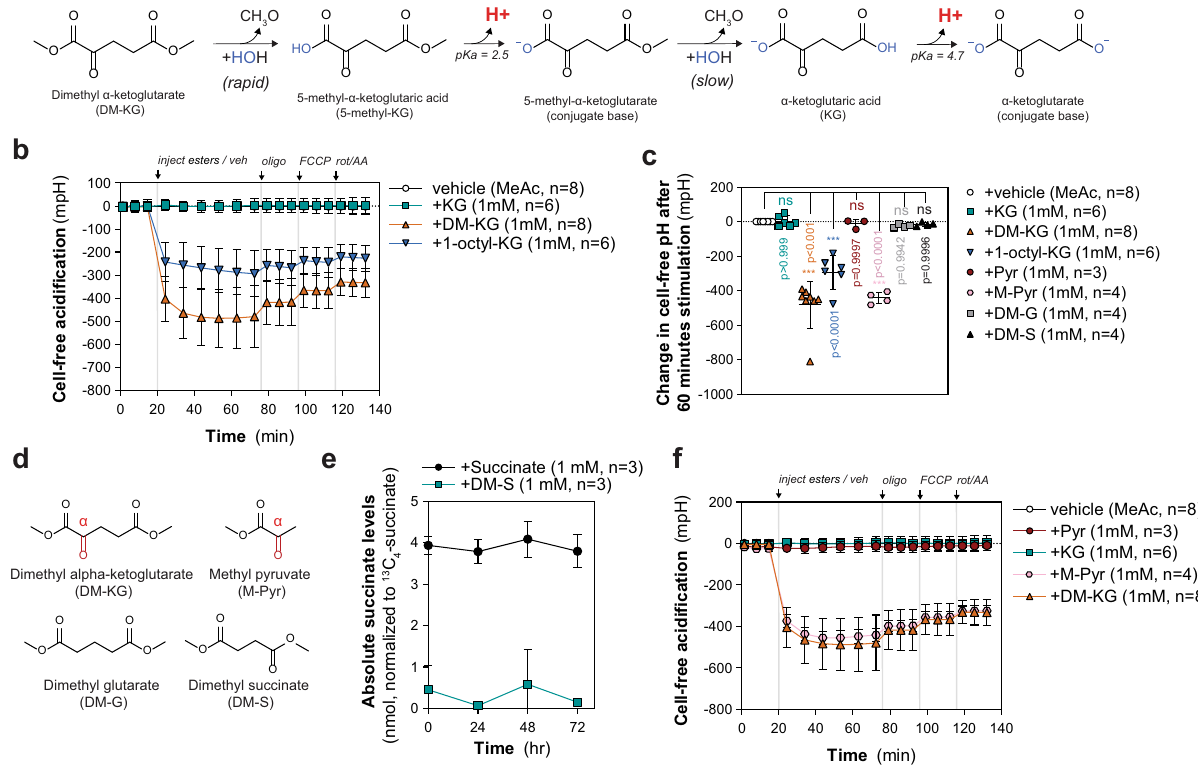
Fig. 4 α -ketoesters signi fi cantly acidify aqueous media as a result of rapid hydrolysis and de-protonation. a Schematic depicting the mechanism of DMKG hydrolysis, formation of α -ketoacid, and subsequent de-protonation that results in signi fi cant acidi fi cation of aqueous media. The fi nal product upon complete hydrolysis is the conjugate base of α -ketoglutarate (KG). b Acidi fi cation of media without cells after injection of methyl acetate or 1 mM of KG, DMKG, or 1-octyl-KG in units of mpH. Data are mean ± s.d. of n = 6 (KG, 1-octyl-KG) or 8 (methyl acetate, DMKG) biologically independent experiments. c Change in media pH (in mpH) after 60-m stimulation with methyl acetate or 1 mM of KG, DMKG, 1-octyl-KG, pyruvate (Pyr), methyl pyruvate (M-Pyr), dimethyl-glutarate (DM-G), or dimethyl-succinate (DM-S). Data are mean ± s.d. of n = 3 (Pyr), 4 (M-Pyr, DM-G, DM-S), 6 (KG, 1-octyl-KG), or 8 (methyl acetate, DMKG) biologically independent experiments; signi fi cance determined by one-way ANOVA using Dunnett ’ s multiple comparisons test, n.s. p > 0.05, *** p < 0.0001. d Chemical structures of DMKG, methyl pyruvate (M-Pyr), dimethyl-glutarate (DM-G), and dimethyl-succinate (DM-S). The α -keto group is colored in red and marked with “ α ” symbol for emphasis. e Time course of absolute succinate levels resulting from double hydrolysis of 1 mM of dimethyl-succinate (DM-S) over 72 h compared to 1 mM of succinate. Hydrolysis was performed in cell-free conditions. Data are mean ± s.d., n = 3 biologically independent experiments. f Acidi fi cation of media without cells after injection of methyl acetate or 1 mM of Pyr, M-Pyr, KG, or DMKG in units of mpH. Data from Fig. 4a included for KG and DMKG for comparison to acidi fi cation caused by M-Pyr. Data are mean ± s.d. of n = 3 (Pyr), 4 (M-Pyr), 6 (KG), or 8 (methyl acetate, DMKG) biologically independent experiments. b , f Cell-free assays run in parallel with in-cell assays from Fig. 3, which is why sequential injections of oligomycin, FCCP, and rotenone with antimycin A were included. Acidi fi cation assays conducted in DMEM containing HEPES (5 mM) buffer. Change in mpH quanti fi ed for each biologically independent experiment by background subtracting vehicle from experimental data and averaging across all